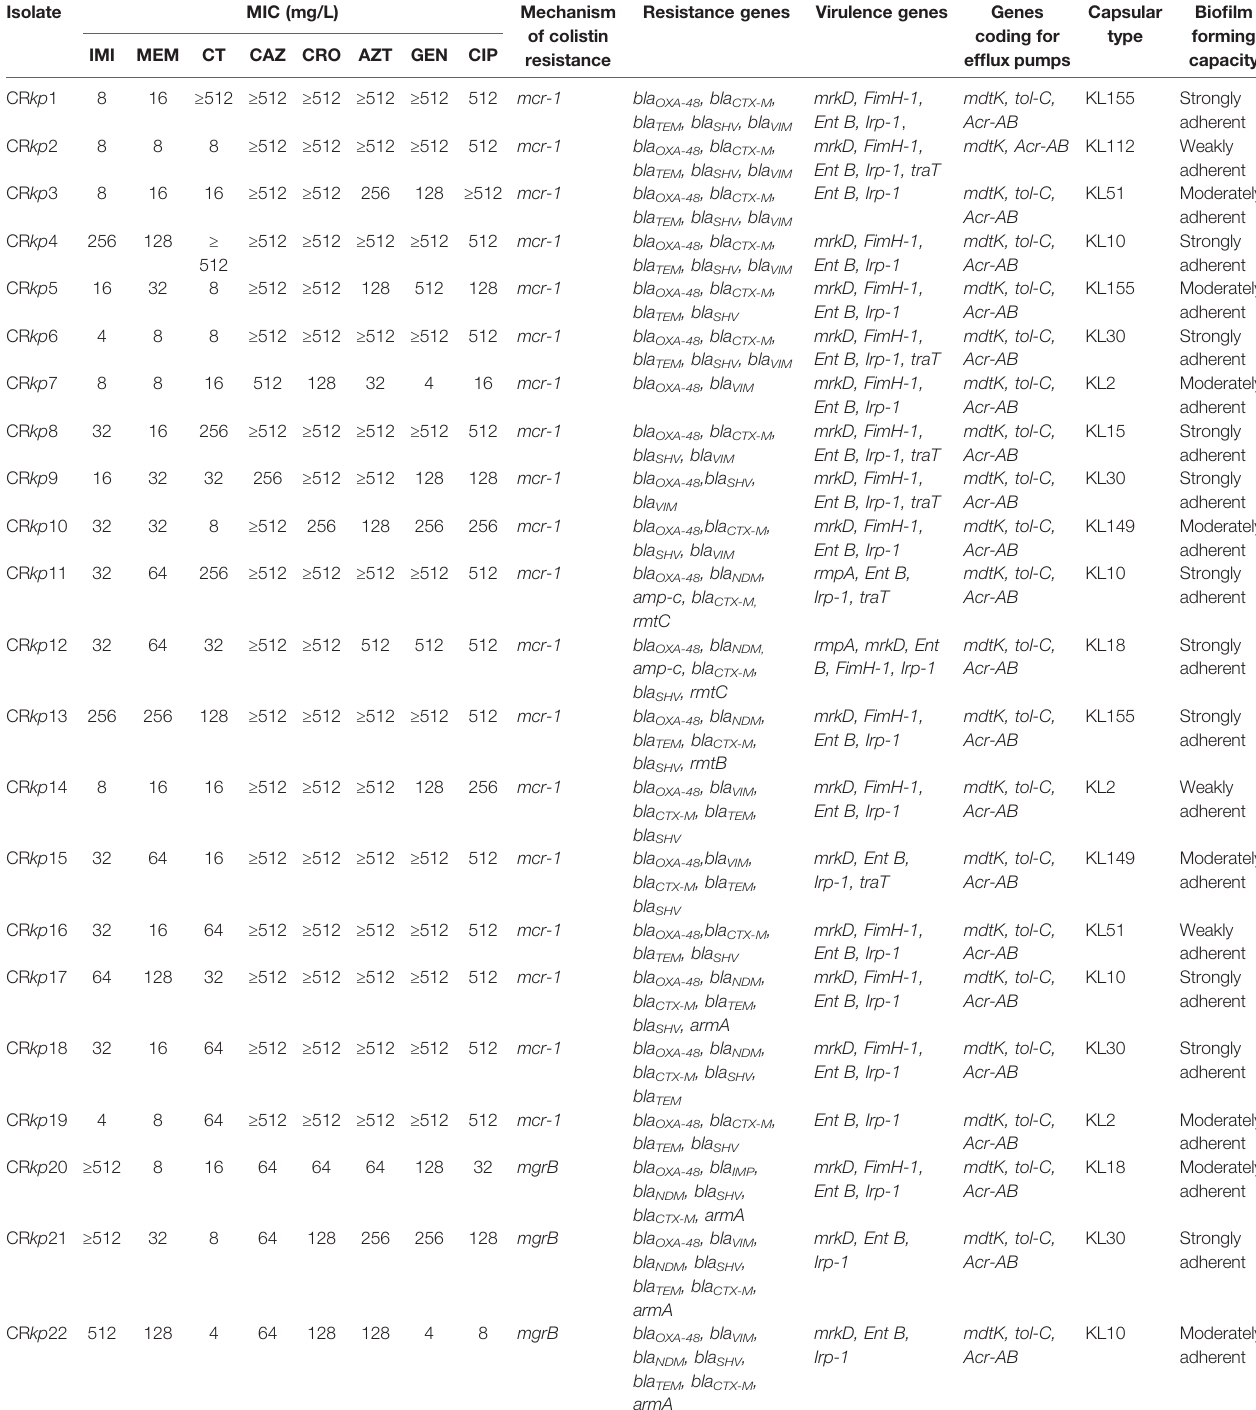
TABLE 2 | Antimicrobial susceptibility pro fi le and molecular characterisation of 22 colistin resistant Klebsiella pneumonia . Isolate MIC (mg/L) Mechanism of